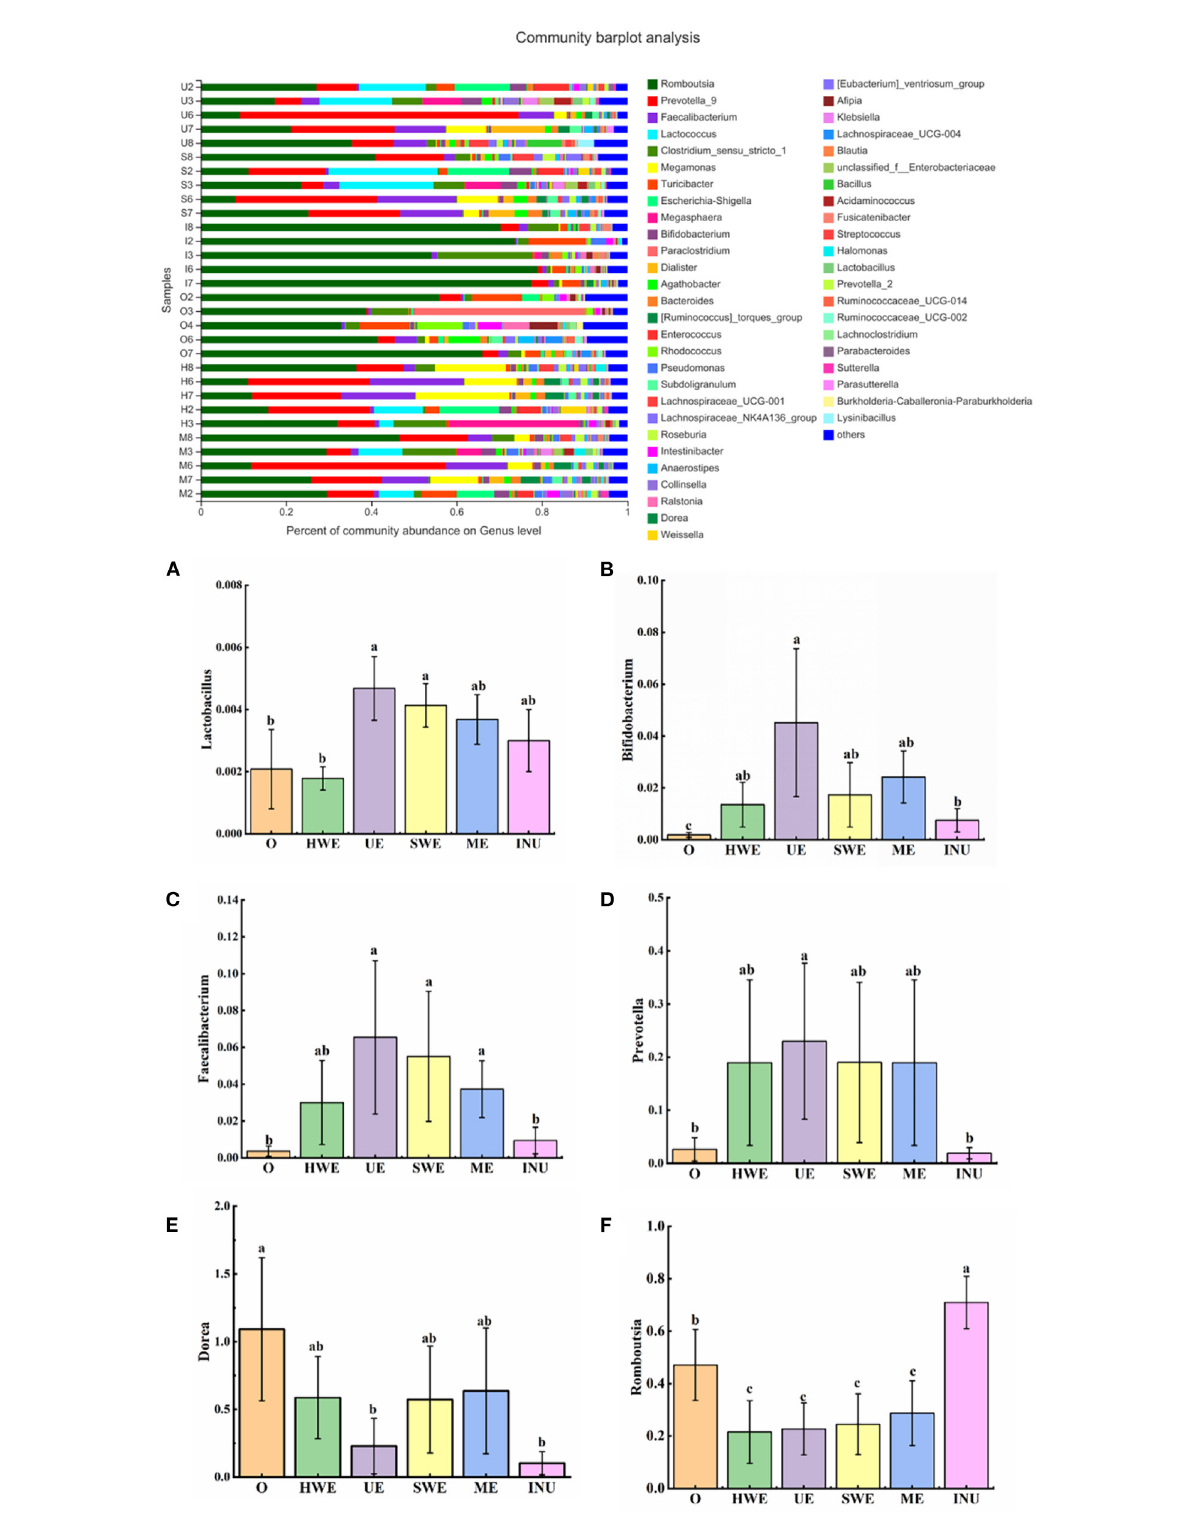
FIGURE8 (A-F) Relative abundance of gut microbiota at the genus level ( n = 5). O stands for blank control group. HWE or H, UE or U, SWE or S, and ME or M stand for dietary fiber extracted with hot water, ultrasonic assisted, subcritical water, and microwave assisted methods, respectively. INU or I stand for inulin. Different letters a, b and c indicate significant differences ( p < 0.05), the same letters indicate that the differences are not significant ( p >